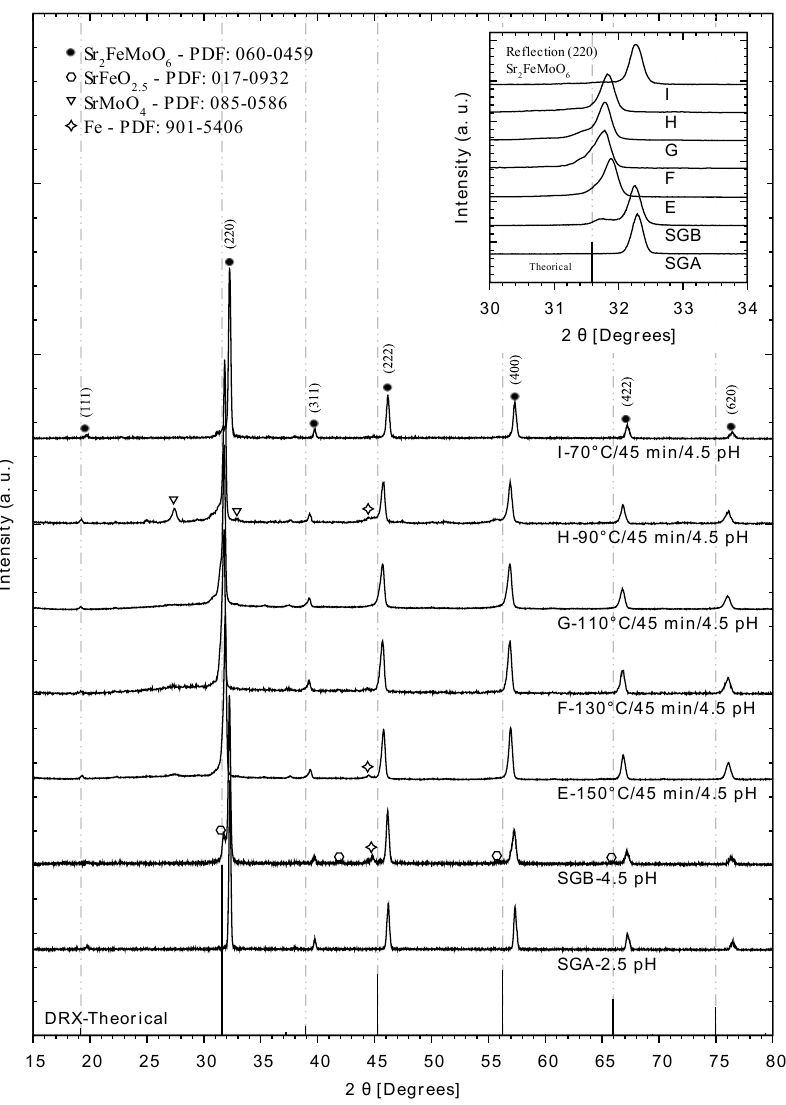
Figure 4. XRD patterns of obtained double perovskite Sr 2 FeMoO 6 after the reduction process referred to the theoretical Bragg reflections (dotted lines) [27]. The condition labels refer to reaction temperature, reaction time, and pH, respectively.